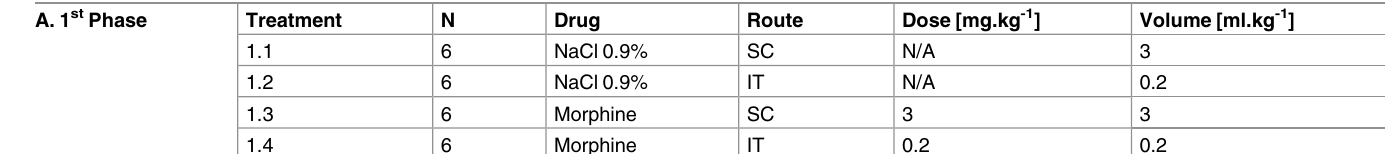
Table 1. Treatment groups in phase 1 of the study.